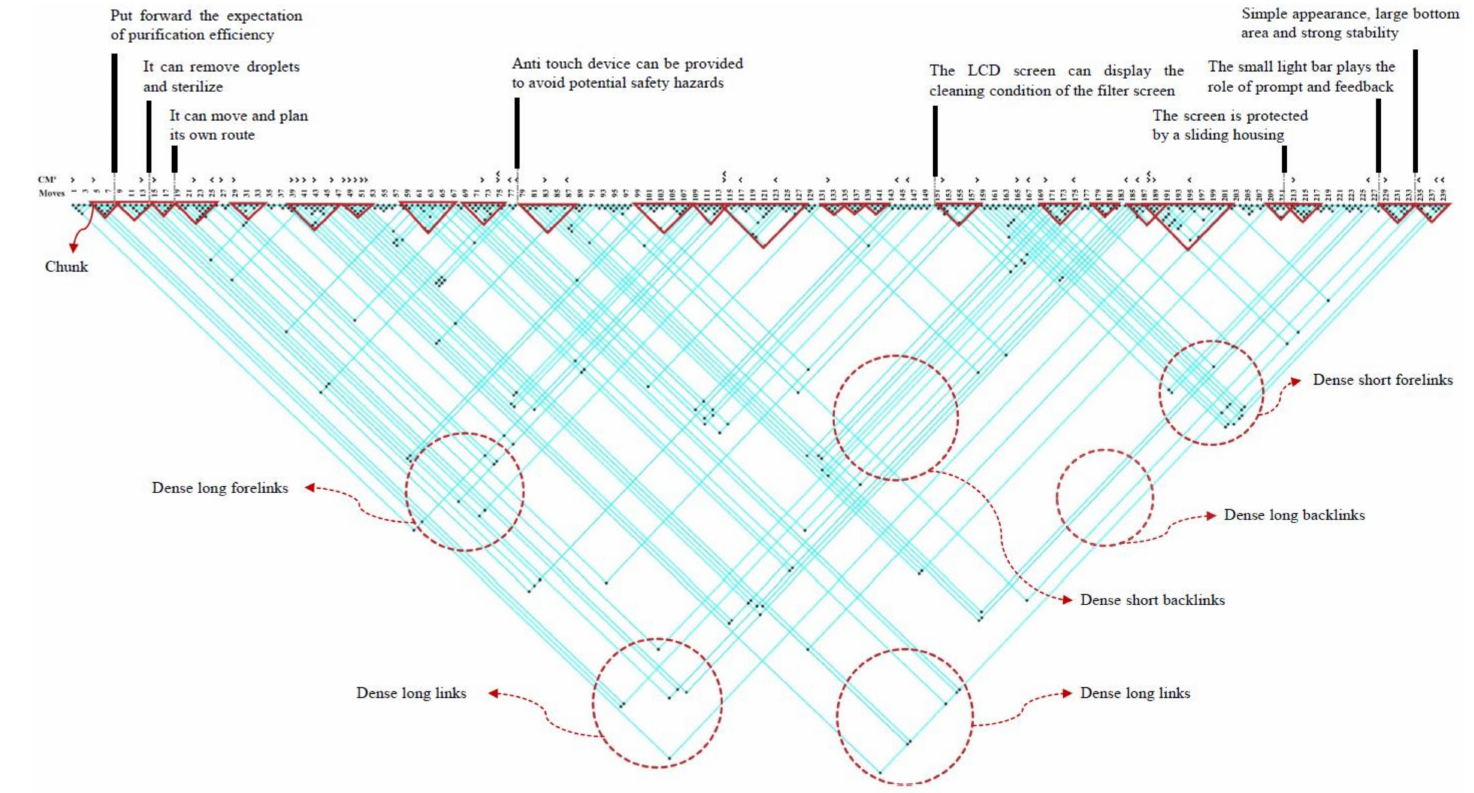
Figure 2. The linkograph of co-design processes between users and